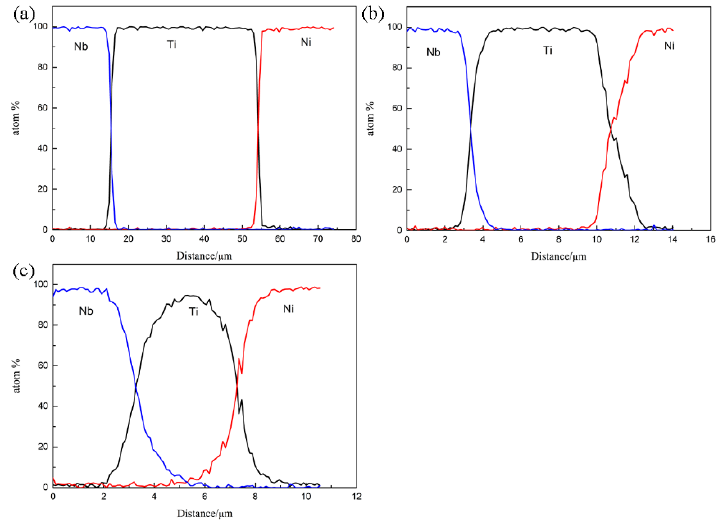
Figure 5. The interface diffusion distance of the Ni/Ti/Nb composite: ( a ) after the third pass, ( b ) after the fourth pass, and ( c ) after the fifth pass.